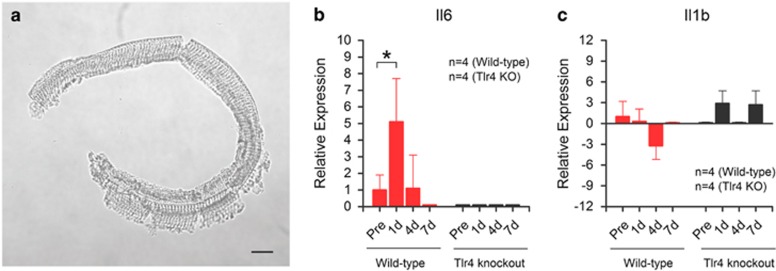
Comparison of the transcriptional expression of inflammatory genes in the organs of Corti of Tlr4 knockout mice and wild-type mice. Five pro-inflammatory genes (Il6, Il1b, Tnf, Ccl2 and Ccl4) were examined in organs of Corti collected before and at three time points (1, 4 and 7 days) after acoustic injury. Among the five examined genes, two (Il6 and Il1b) were detected in the organ of Corti; these data are presented in the figure. (a) A micrograph showing a typical organ of Corti used for the expression analysis of pro-inflammatory genes. Bar=60 μm. (b) A comparison of Il6 expression between Tlr4 knockout and wild-type mice. The expression level is significantly increased at 1 day after acoustic injury (one-way ANOVA, F (2, 9)=5.79, P=0.024; Tukey test, P=0.036). By 4 days after injury, the increase level has decreased to the pre-noise level (Tukey test, P=0.99). At the 7-day time point, expression was not detected. For Tlr4 knockout mice, the expression of Il6 was detected neither before nor after acoustic injury. (c) Comparison of Il1b expression between wild-type and Tlr4 knockout mice. Although the expression levels vary among groups, none of these differences are statistically significant